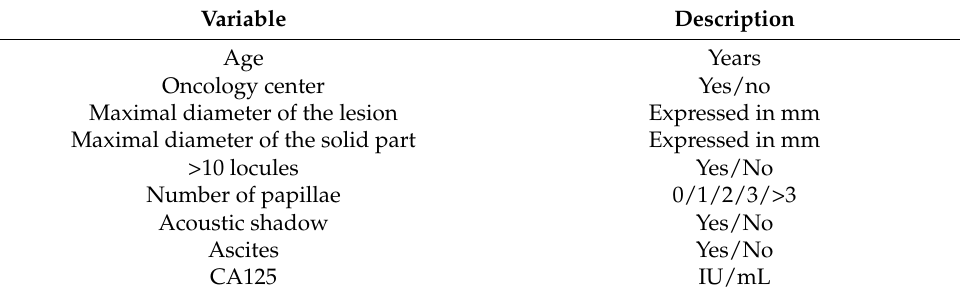
Table 2. Variables assessed in the ADNEX model. Variable